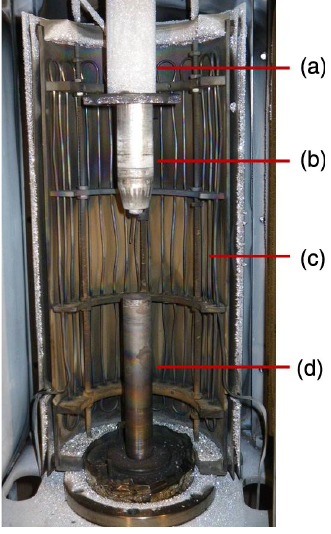
FIG. 1 (color online). HPCVD setup for coating rf cavities with MgB 2 . (a) Stainless steel tube sample holder capable of rotational and linear movement; (b) water-cooled diborane supply line; (c) clam-shell heater; and (d) Mg oven.